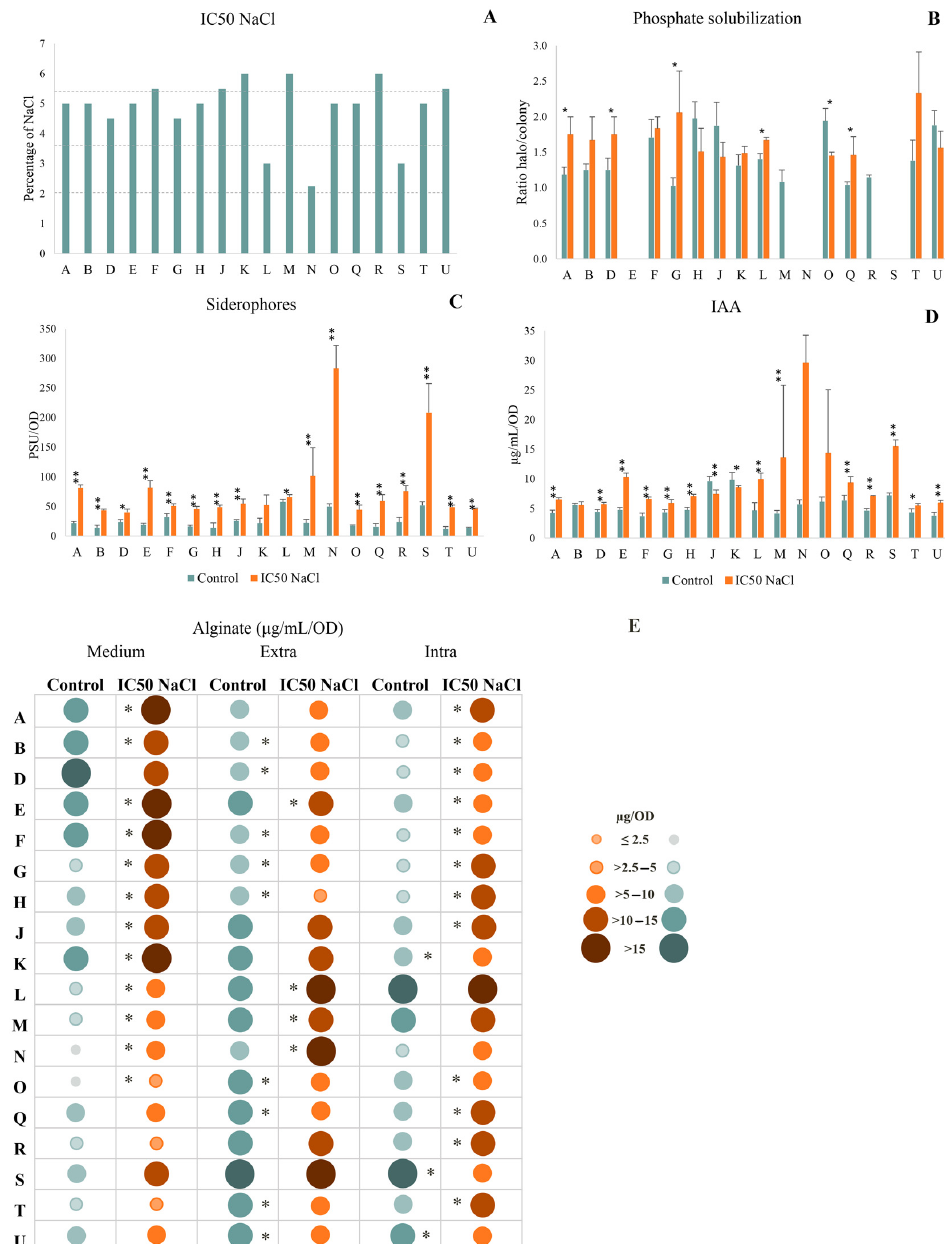
Figure 2. Effect of salinity on bacterial ability to produce PGP traits: ( A ) Percentage of NaCl that inhibits 50% bacterial growth (IC 50 NaCl); ( B ) Phosphate solubilization, expressed by the ratio between halo and colony diameter; ( C ) Siderophore production, expressed in percent siderophore units per optical density (PSU/DO); ( D ) Indole acetic acid (IAA), expressed in μ g/mL/OD and ( E ) alginate distribution in three fractions (medium, attached extracellularly to the cell wall–Extra and intracellular-Intra), expressed in μ g/mL/DO. Bacterial strains: Pantoea sp. (A); Klebsiella sp. (B); Pseudomonas sp. (D); Pseudomonas sp. (E); Acinetobacter sp. (F); Stenotrophomonas sp. (G); Enterobacter sp. (H); Enterobacter sp. (J); Pantoea sp. (K); Pseudomonas sp. (L); Rhizobium sp. (M); Paenarthrobacter sp. (N); Ochrobactrum sp. (O); Pseudomonas sp. (Q); Rhizobium sp. (R); Stenotrophomonas sp. (S); Pseudomonas sp. (T); Enterobacter sp. (U). Values are means of three replicates + standard deviation. Significant differences compared to control (non-inoculated and non-salt exposed plants) were marked with single asterisks ( p < 0.05) or double asterisks ( p < 0.01). For means, standard deviation and statistical significance see Supplementary Table S2.